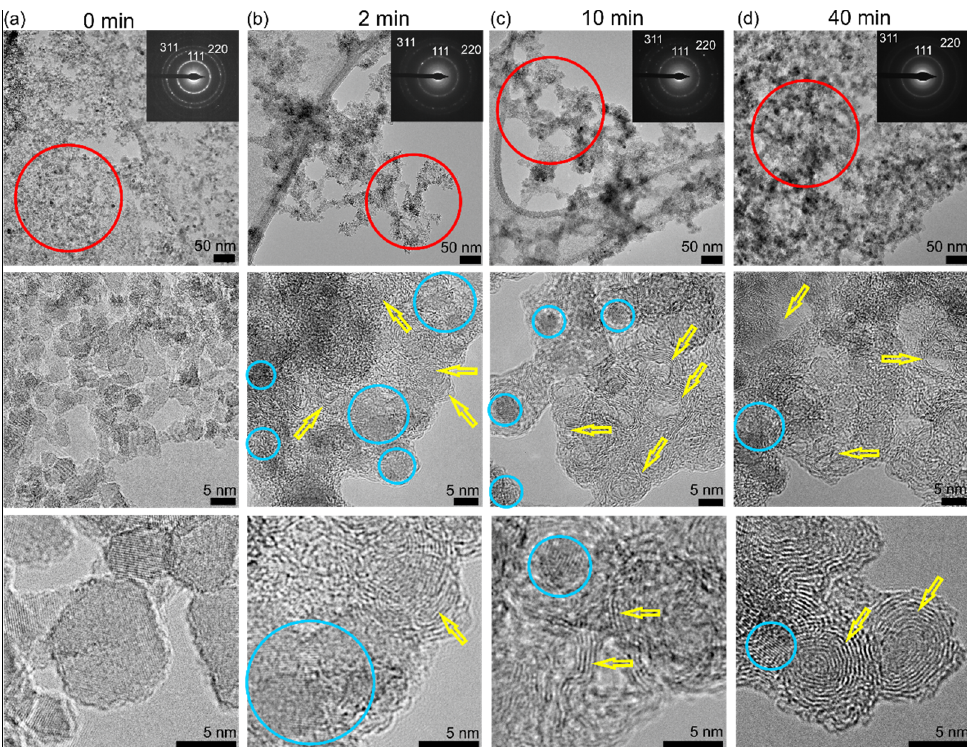
Figure 5. TEM images and electron diffraction patterns of the pristine (0 min) H-DNDs ( a ), and samples irradiated for 2 min ( b ), 10 min ( c ), and 40 min ( d ). The yellow arrows indicate the laser irradiation-created OLC structure, the blue circles denote the diamond crystalline structure.